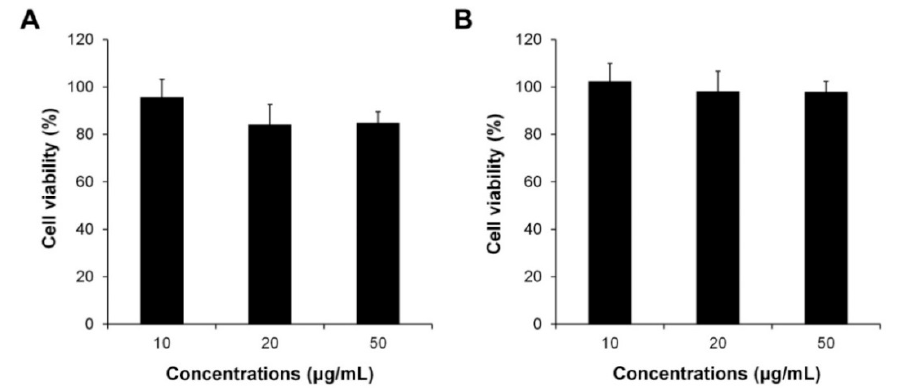
Figure3. CytotoxicityevaluationofCS–FNPsagainst( A )hDFBand( B Figure 3. Cytotoxicity evaluation of CS–F NPs against ( A ) hDFB and ( B ) PC-3 cells at different concentrations.